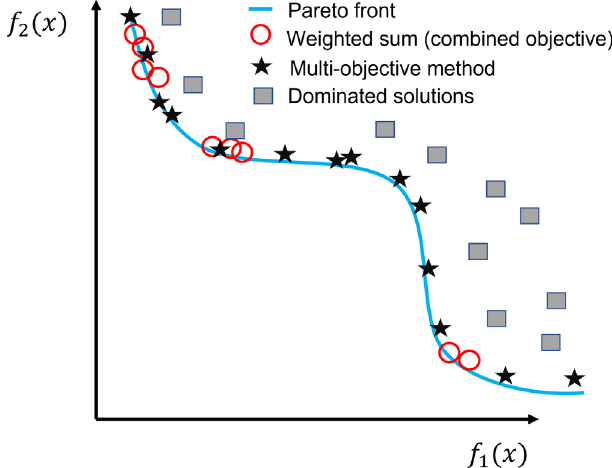
FIG. 2. Pareto front for two objectives showing the benefits of MO methods over weighted sum optimization methods. Adapted from Ref.